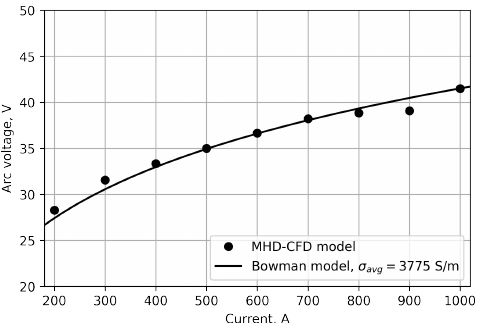
Figure 7. Comparison of computational model results with the Bowman empirical model. x CO = 1.0, L a = 0.01 m.